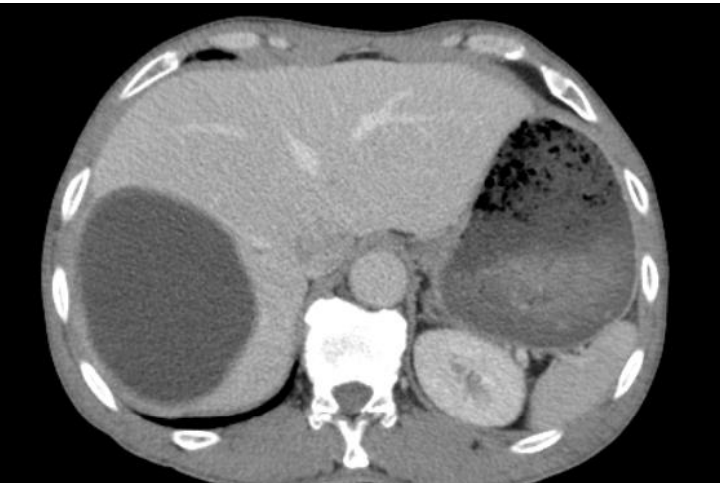
Figure 7. Selected CT images of a 35-year-old female showing a well-circumscribed, round, unilocular hypodense cystic lesion centered in segment IV of the right hepatic lobe, measuring about 10 × 7.7 × 6.3 cm with no internal septation or solid component, no frank calcifications, or enhanced internal component after contrast administration, which is a typical image of hydatid cyst Type I. Diagnostics 2023 , 13 , x FOR PEER REVIEW